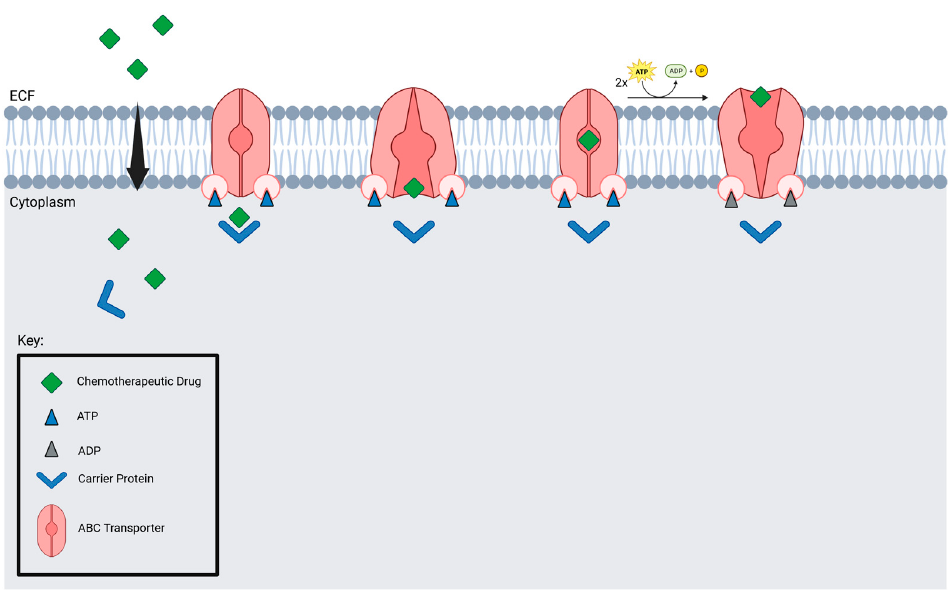
Figure 5. ABC transporter mechanism of action.